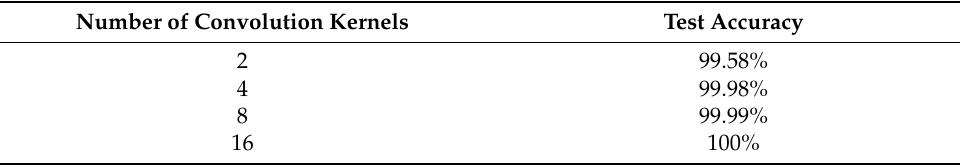
Table 4. Comparative experimental analysis of the number of convolution kernels.